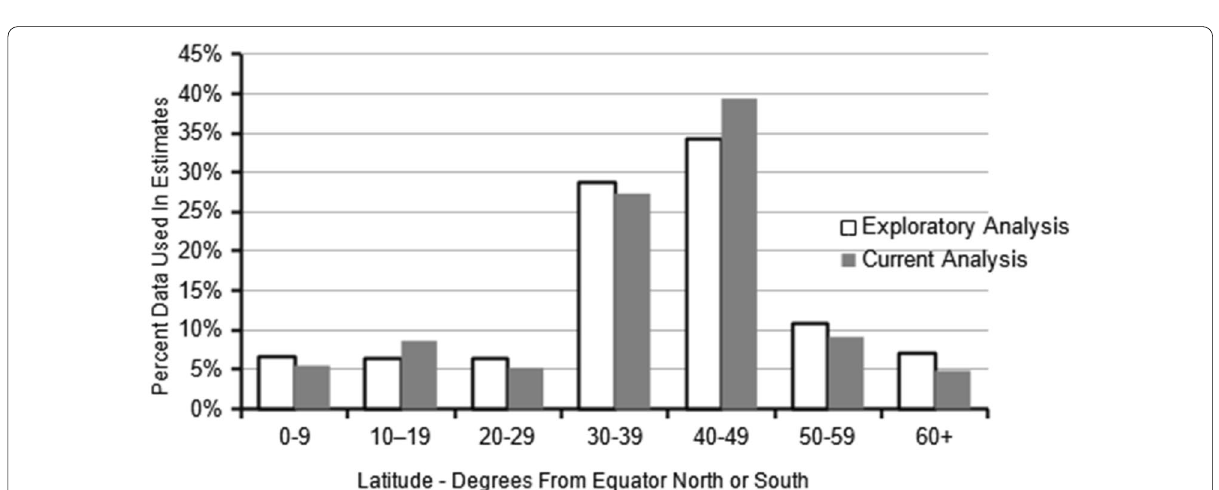
Fig. 1 Comparison of range of onset location latitudes for current and exploratory analyses for patients with bipolar I disorder (N